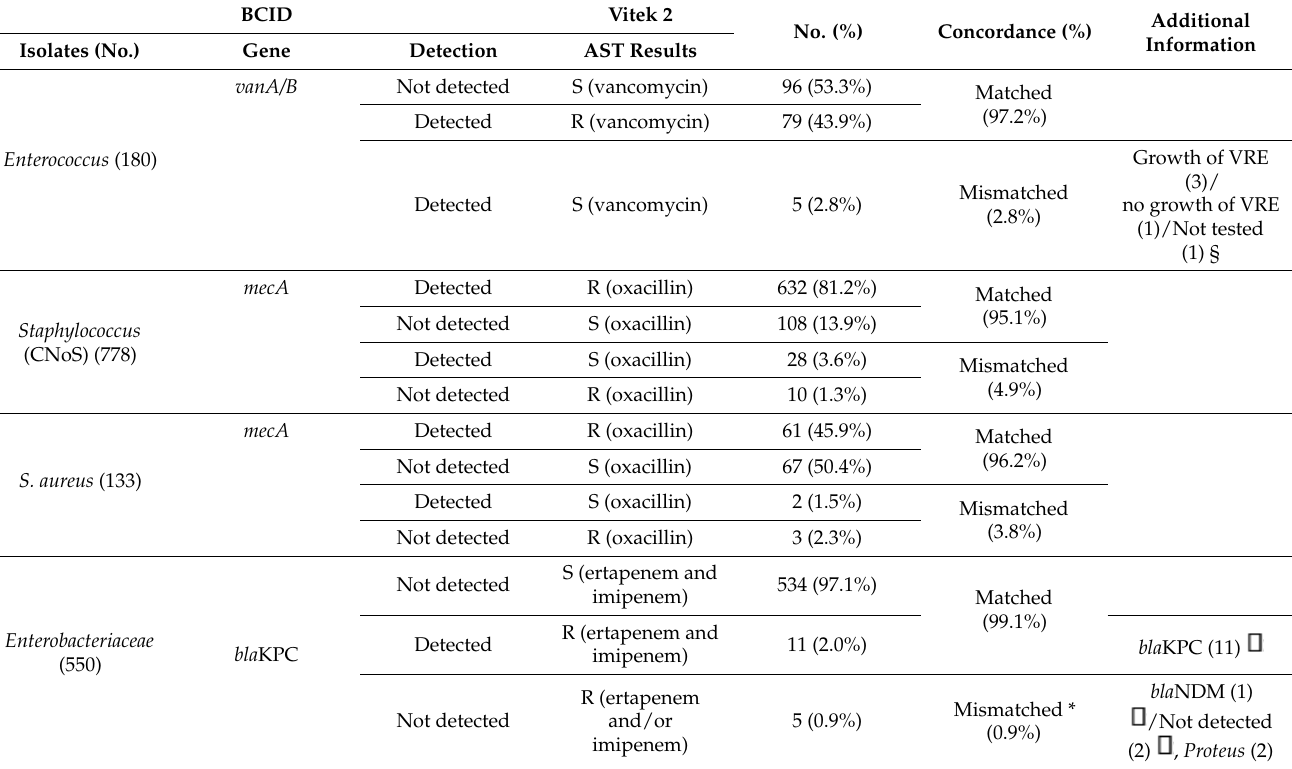
Table 5. Investigation of antimicrobial resistance genes as detected by BCID in comparison to using